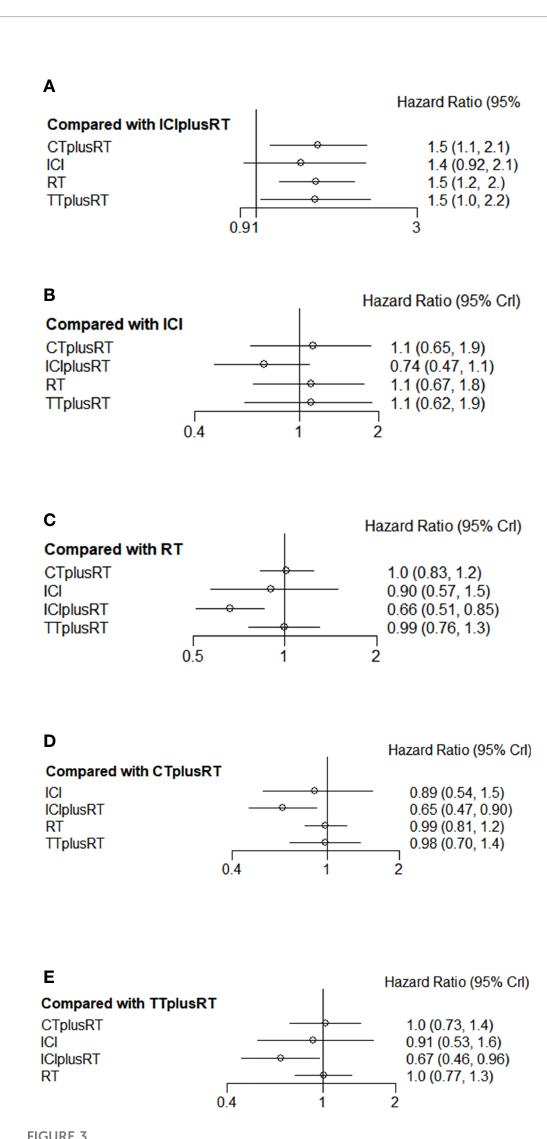
FIGURE 3 Forest plots of multivariable interventions for OS. (A) Compared with Immune checkpoint inhibitor combined with radiotherapy (ICIplusRT); (B) Compared with Immune checkpoint inhibitor (ICI); (C) Compared with radiotherapy (RT); (D) Compared with chemotherapy combined with radiotherapy(CTplusRT); (E) Compared with targeted therapy combined with radiotherapy (TTplusRT).